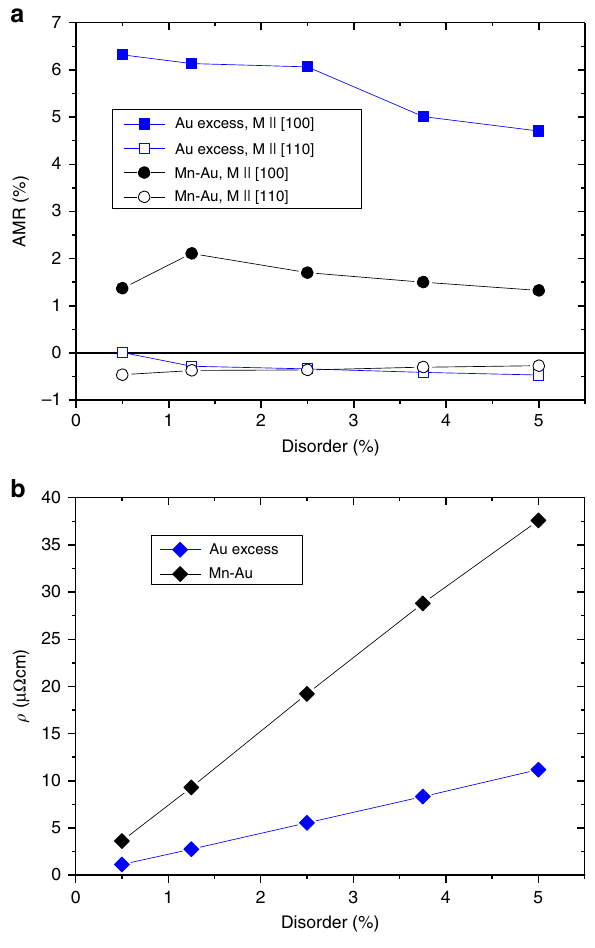
Fig. 5 Calculated AMR. a Calculated AMR of Mn 2 Au for different degrees of disorder due to Au excess and due to Mn – Au site swapping with dependence on the Néel vector orientation. b Calculated residual resistivities of Mn 2 Au for different degrees disorder due to Au excess and due to Mn – Au site swapping